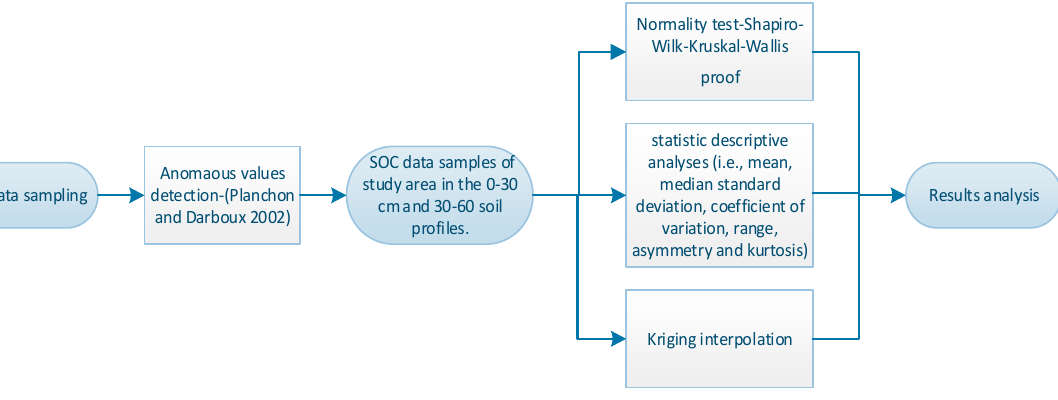
Figure 2. Process of evaluation and prediction of SOC.